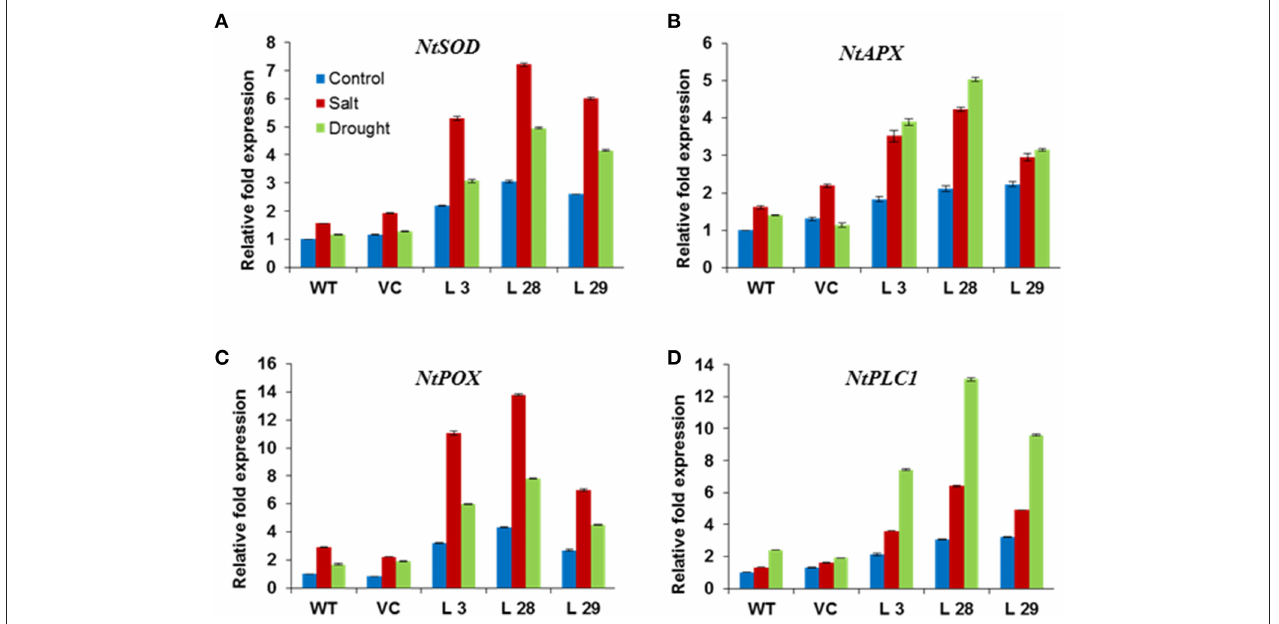
FIGURE 7 | Expression of ROS-scavenging (A) NtSOD , (B) NtAPX , (C) NtPOX, and signaling (D) NtPLC1 genes in SbSLSP transgenic plants, and VC and WT plants under salinity and drought stress using real-time PCR. Actin was used as an internal control. Data represents the mean ± SD of three